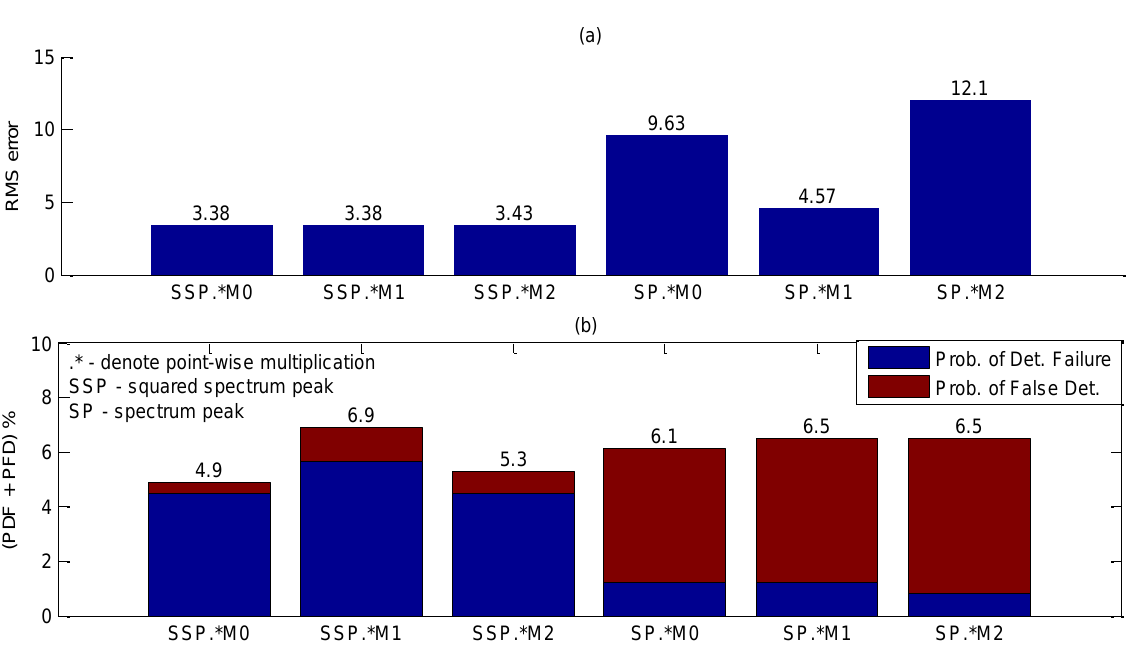
Figure 16. Accuracy results of interfacial detection with transducer obstructed by a metallic plate for shape parameters combined by point-wise multiplication. ( a ) RMS error results. ( b ) Probability of false detection and detection failure results.